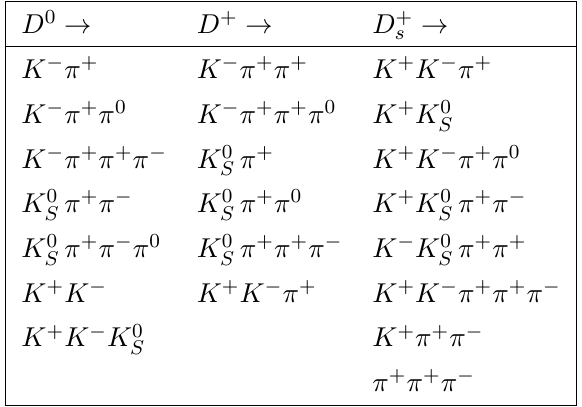
Table 10 . Decay channels of D 0 , D + and D +